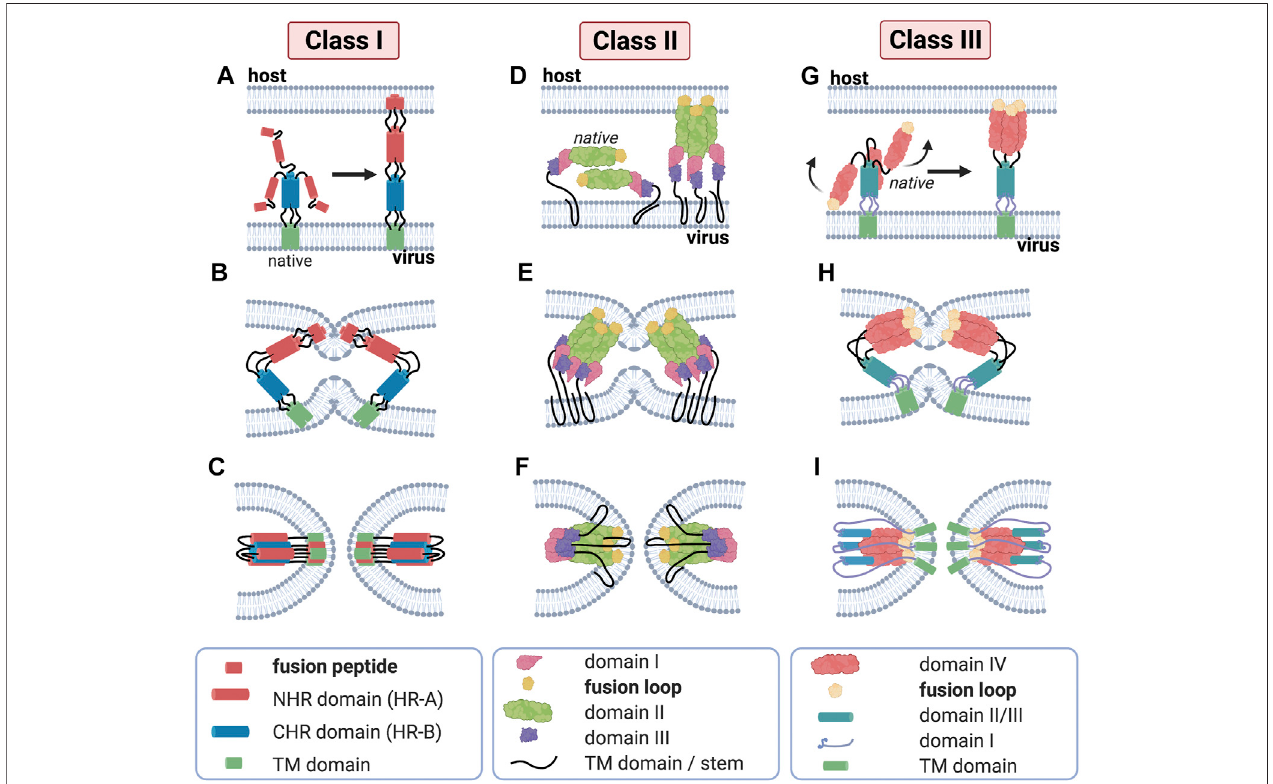
FIGURE 3 | Major structural features of membrane fusion processes across the three canonical classes of fusion protein. (Column 1) Membrane fusion driven by viral class I proteins. The model of class I protein-mediated hemifusion and fusion depicts the progression through an extended prehairpin followed by breaking the threefoldsymmetryanddissociationofthe C -heptadrepeatdomains.Inthenativeprefusionconformation,theparamyxovirusfusion(F)proteinconsistsofglobularhead domain attached to the transmembrane (TM) domains and short luminal tails through the TM domain-proximal heptad repeat sequences. When fusion commences,majorstructuralrearrangementsleadtoassemblyofthehead-domainHRsegmentsintoacentral,trimericalpha-helicalcoiled-coilstructure,displacingthe fusion peptides in the direction of the host-cell membrane (A) . Subsequent hairpin-like refolding (B) then positions the heptad repeat domains into the grooves of the centraltriplehelix,resultingintheformationofthestablesix-helixbundle(6HB)post-fusionstructure (C) ,inwhichthefusionpeptide-proximalcorecoiled-coilstructureis surrounded by the three TMD-proximal HR helices; this is a de fi ning feature of fusion proteins of this class. (Column 2) Class II viral protein-mediated fusion. Homo-/ hetero-di-/trimers of E1/E2 (D) engage a target membrane with their fusion loops following low pH-induced conformational changes. Subsequent conformational changes involve the reorientation of domain III around a hinge region (E) that positions the TM region and the fusion loop (yellow) proximal to one another. Subsequent refolding of the extended trimeric conformation into a hairpin structure promotes hemifusion and fusion pore formation (F) . Despite their marked structural differences, proteinsofclassIandclassIIareabletoprogressthroughasimilarrefoldingpathway.(Column3)Membrane mergerinducedbyclassIIIviralfusogens.Thenativetrimer of class III fusion proteins folds into a tripod-like arrangement, on which the fusion loops are positioned at the tip of each leg and are therefore directed into the viral envelope. Low pH conditions result in the protonation of a speci fi c cluster of histidine residues that exert a major destabilizing effect on the prefusion structure. Once triggered, the tripod legs are proposed to swing upward (G) , driving the fusion loops toward the target membrane. Repositioning of the domains with conserved tertiary structure relative to each other through secondary structure reorganization in hinge regions and major changes of the trimerization domain (H) then ultimately result in a classic hairpin post-fusion conformation (I) .